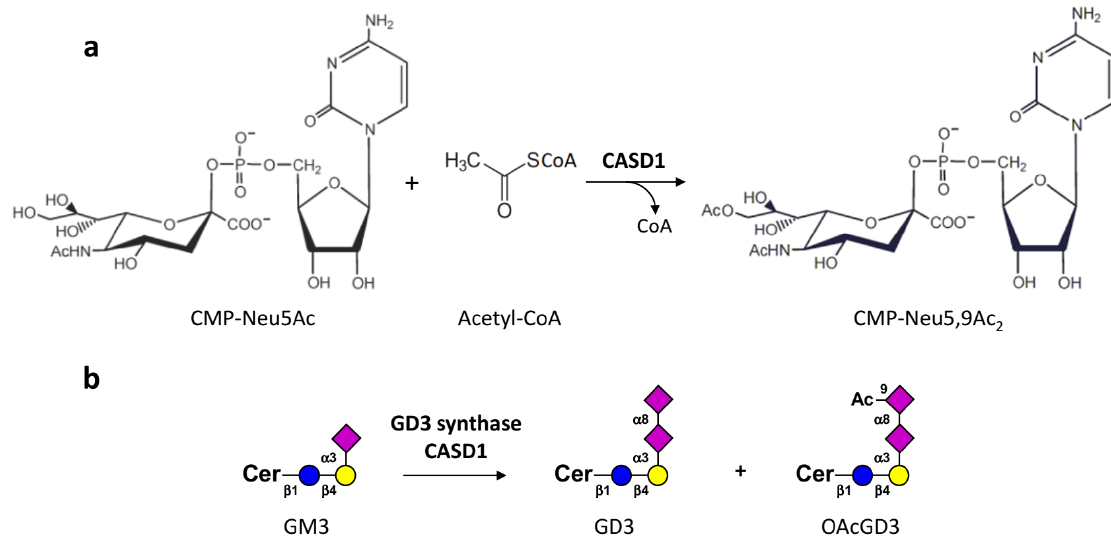
Figure 2. Current knowledge on CASD1 sialate- O -acetyltransferase activity. ( a ) CASD1 SOAT activity on CMP sialic acid, generating CMP-Neu5,9Ac 2 was proposed by Baumann et al., 2015 [25] ( b ) In HAP-1 cells, the expression of GD3S induced the formation of GD3 and 9- O